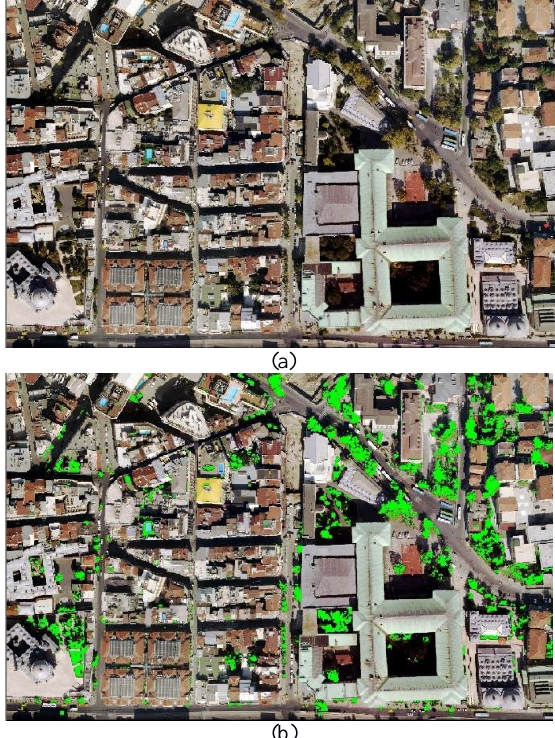
Figure 2. (a) Input multispectral image and automated extracted (b) Vegetation based on NGBDI. For vegetation extraction, mean red band with an empirical value of less than 150, the number of returns from LiDAR data with an empirical value of 0.6 and NGBDI with an empirical value of greater than 0.17 is combined. From the relative elevation, unclassified areas with an elevation of fewer than 3 meters are considered as ground areas where building objects are classified from regions with an elevation of greater than 3